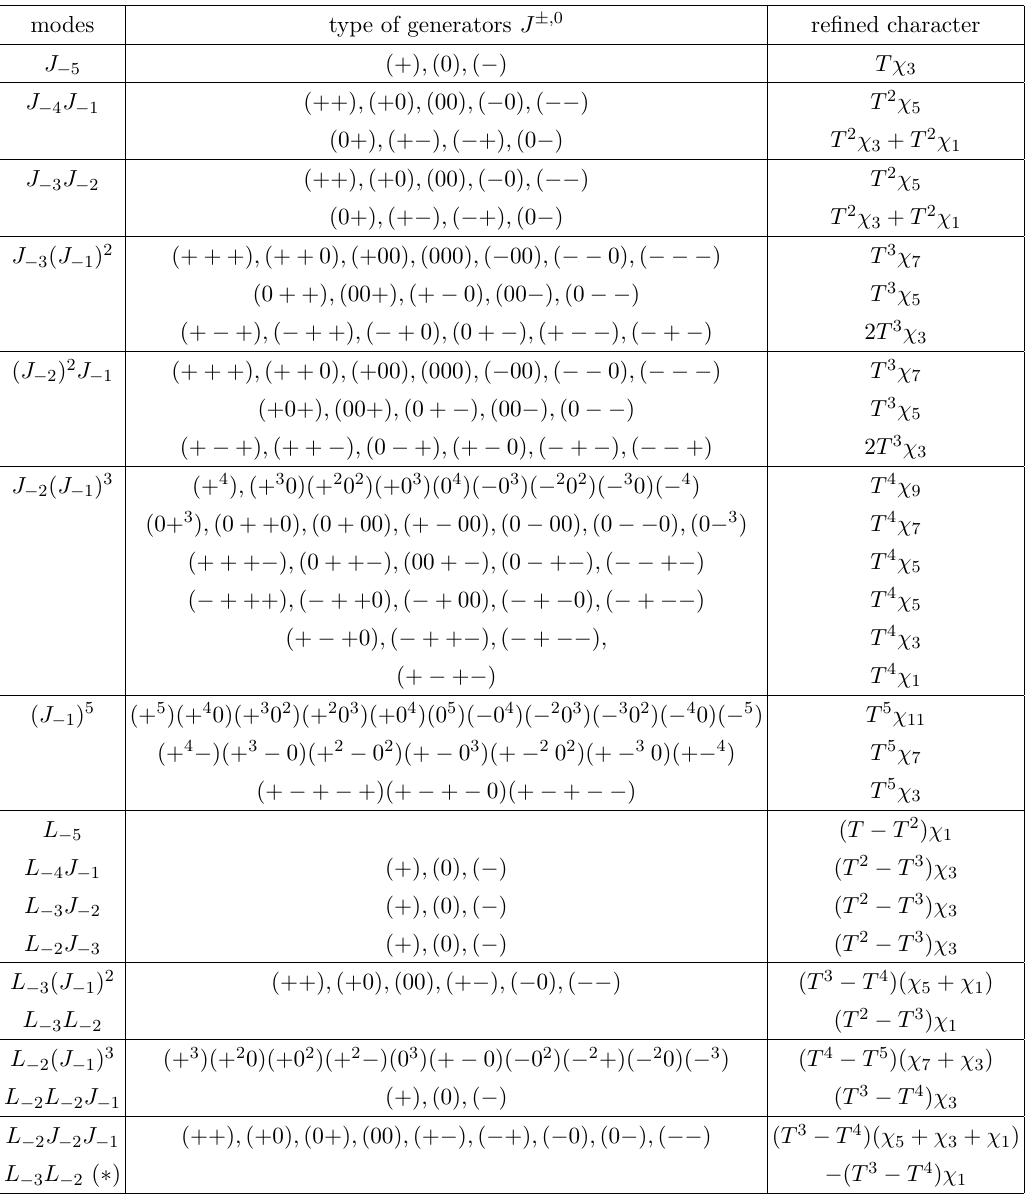
Table 3 . States of a generic vacuum module at level 5. One should be careful here not to overcount the states. The last entry with (*) is there to remove one super(cid:13)uous state that is given by a